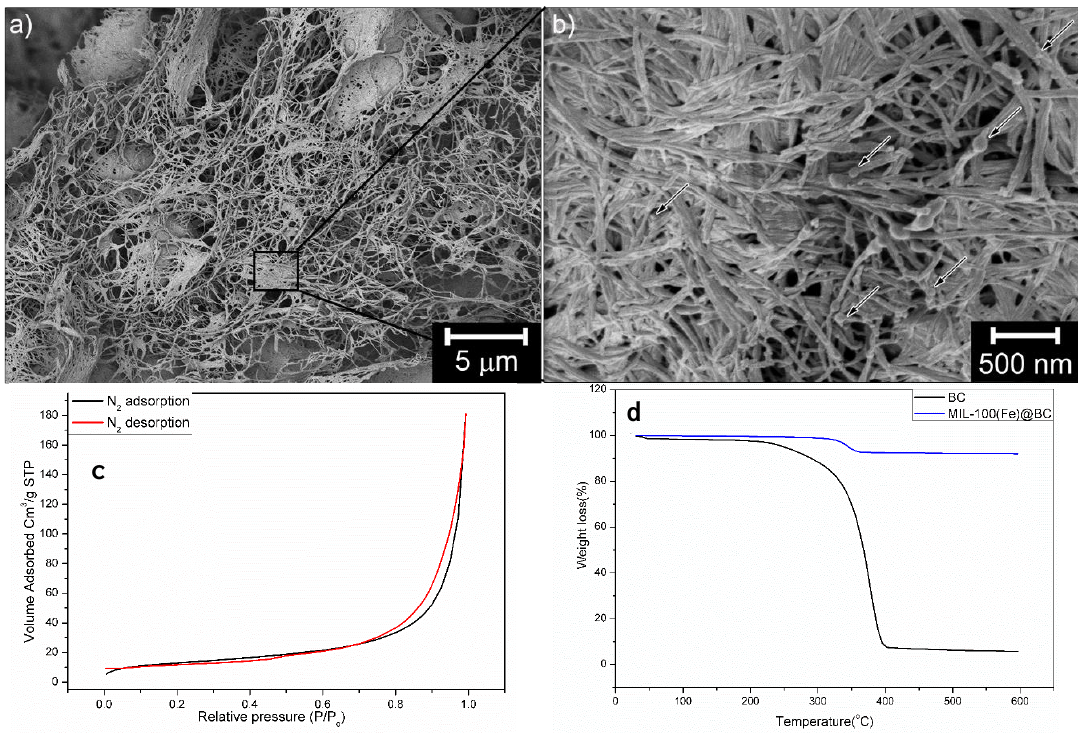
Figure 1. ( a , b ) SEM image of hybrid MIL-100(Fe)@BC nanocomposite (BTC / Fe(III) = 120), ( c ) Brunauer- Figure 1. ( a ) and ( b ) SEM image of hybrid MIL-100(Fe)@BC nanocomposite (BTC/Fe(III) = 120), ( c ) Emmett-Teller (BET) analysis of MIL-100(Fe)@BC (BTC / Fe(III) = 120), and ( d ) thermogravimetric analysis Brunauer‒Emmett‒Teller (BET) analysis of MIL-100(Fe)@BC (BTC/Fe(III) = 120), and ( d ) (TGA) of bacterial cellulose (BC) and thermogravimetric analysis (TGA) of bacterial cellulose (BC) and MIL-100(Fe)@BC.